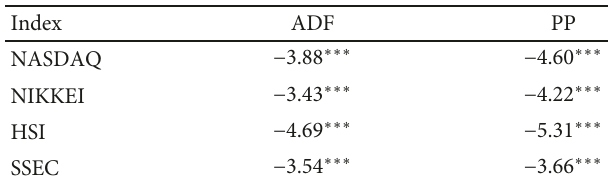
Table 5: Unit root test for LPPL residuals. We reject the null hypothesis; that is, the residuals have a unit root, at 1% signi fi cance level ( ∗∗∗